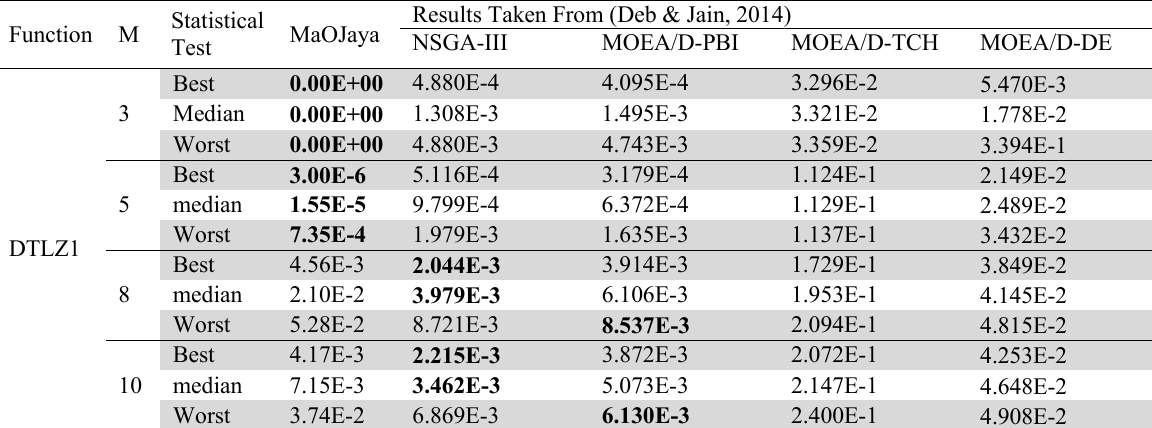
Table 2 Comparison of IGD values of DTLZ1 Function